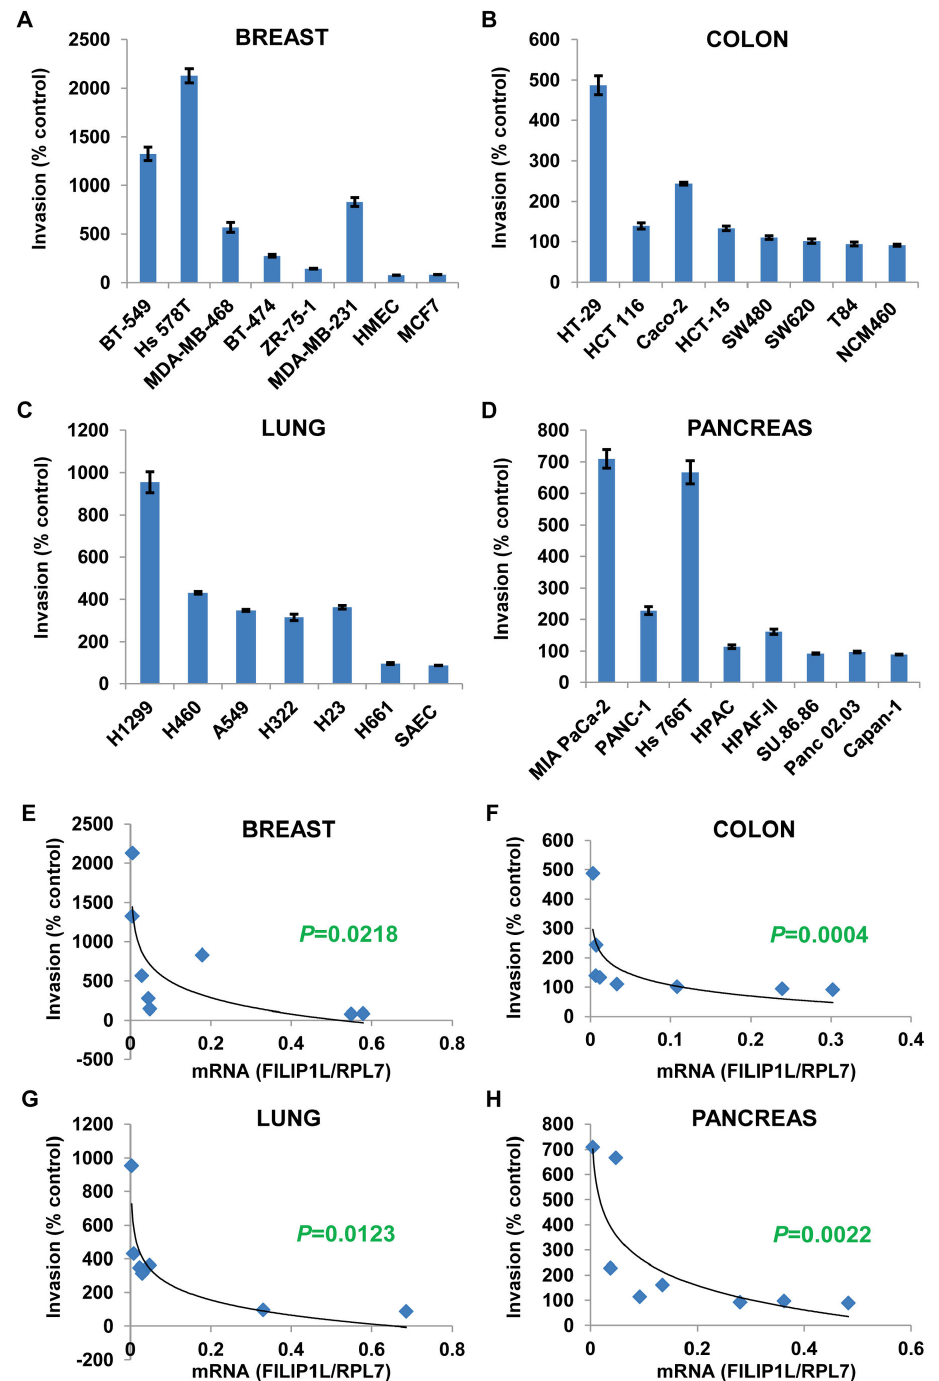
Figure 6. Inverse correlation of FILIP1L expression with the invasive potential of various human cancer cell lines. A - D , Matrigel cell invasion assay for the same cells utilized in Figure 1. Matrigel invasion was measured using the BD BioCoat Tumor Invasion System as described in Materials and Methods . The y axis represents a percent change over serum-free control. Error bars indicate SEM ( n = 4). The result is representative of three independent experiments. E-H , A significant inverse correlation of the FILIP1L mRNA expression with invasiveness of the cells (each P value calculated by Spearman’s rank correlation method). y axis: invasiveness of the cells as a percent change over serum-free control shown in sections A-D was used. x axis: standardized FILIP1L mRNA expression shown in Figure 1 was used. doi: 10.1371/journal.pone.0082620.g006 PLOS ONE |